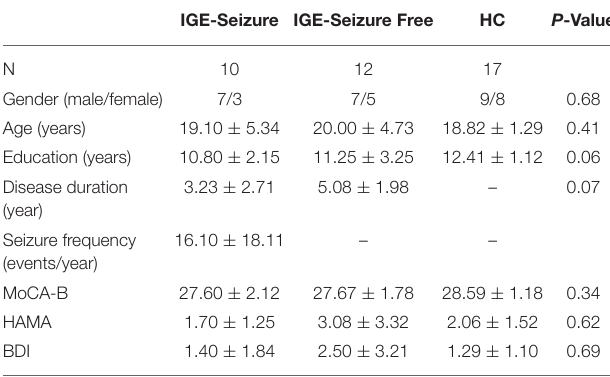
TABLE 1 | Demographic data, background tests and executive functions between the three groups (Mean ±